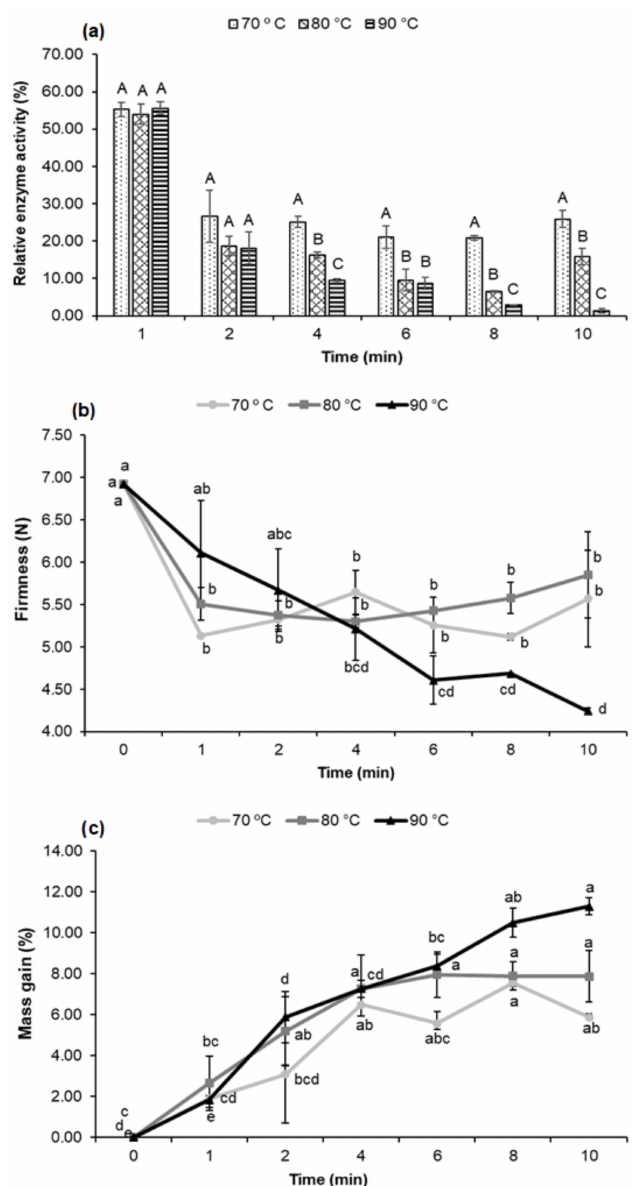
Figure 1. Effect of temperature and blanching time on the relative enzymatic activity (%) of peroxidase ( a ), firmness (N) ( b ) and on the mass gain (%) of fresh cowpeas ( c ). Notes: Mean of two samples and standard deviation bar. REA (%) and Mass gain (%): Each sample was analyzed in triplicate. Firmness (N): Each sample was composed of 15 cowpeas. ABC Means with different letters in each blanching time (min) differ significantly ( p < 0.05) according to the Tukey test. abcd Means with different letters in the same line differ significantly ( p < 0.05) according to the Tukey